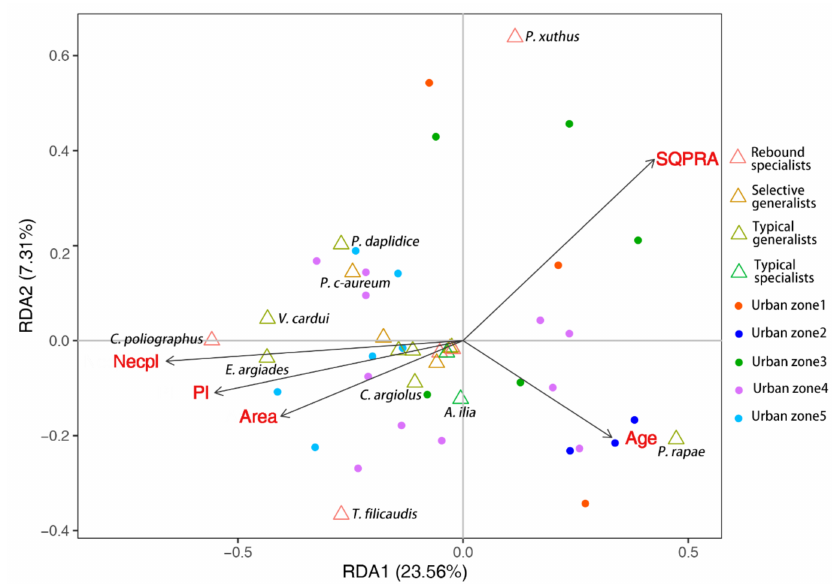
Figure 4. Redundancy analysis plot indicating the influence of each significant explanatory variable ( p < 0.05) on the butterfly community structure. The variables include plant richness (Pl), nectar plant richness (Necpl), park area (Area), age of park (Age) and the square root of the perimeter/area ratio (SQPRA). The triangles represent the butterfly species. The four butterfly groups are represented by different colors. The circles represent the sampling sites. The sites within the five urban zones are shown in different